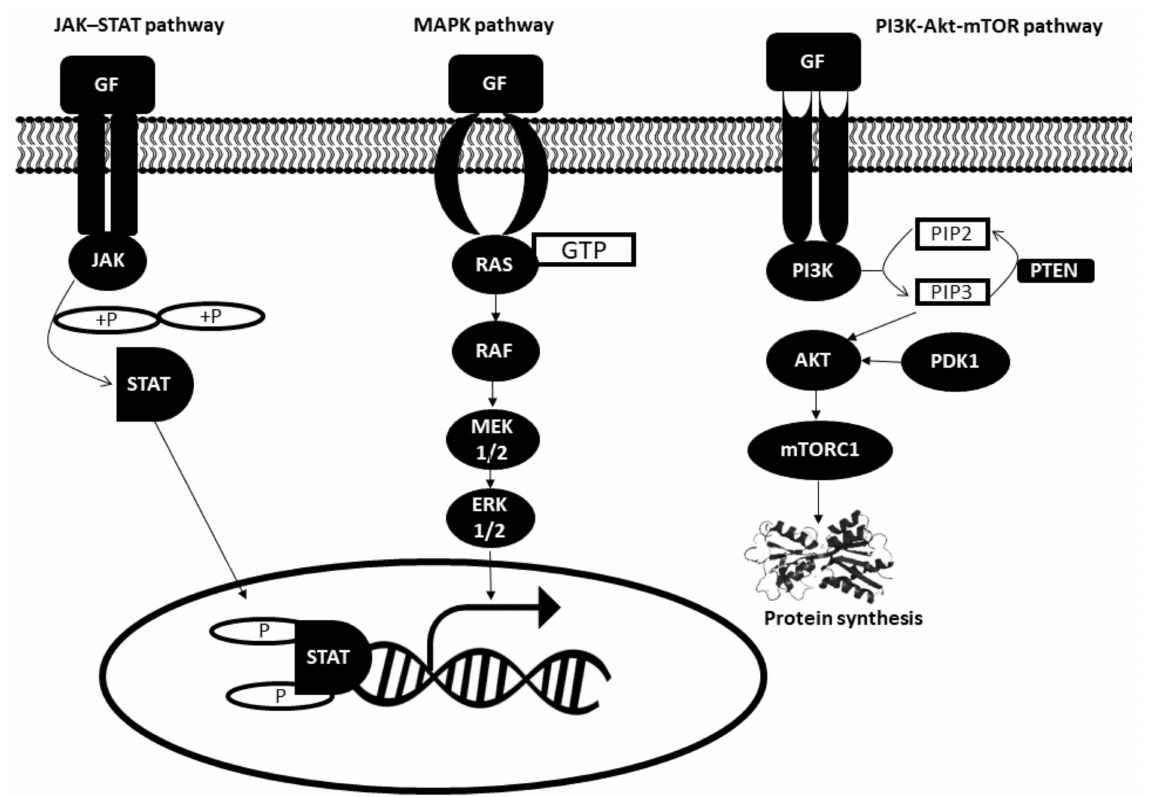
Figure 1. Main players involved in intracellular signalling pathways. GF: Growth factor; JAK: Janus tyrosine kinase; STAT: Signal transducer and activator of transcription proteins; MAPK: Mitogen-activated protein kinase; MEK: Mitogen-activated protein kinase; ERK: Extracellular-signal-regulated kinase; PI3K: Phosphatidylinositol 3 kinase; mTOR: Mammalian target of rapamycin; PDK1: Phosphoinositide-dependent kinase 1; PIP2: phosphatidylinositol 4,5-biphosphate; PIP3: phosphatidylinositol 3,4,5-triphosphate; PTEN: phosphatase and tensin homolog; P: Phosphate